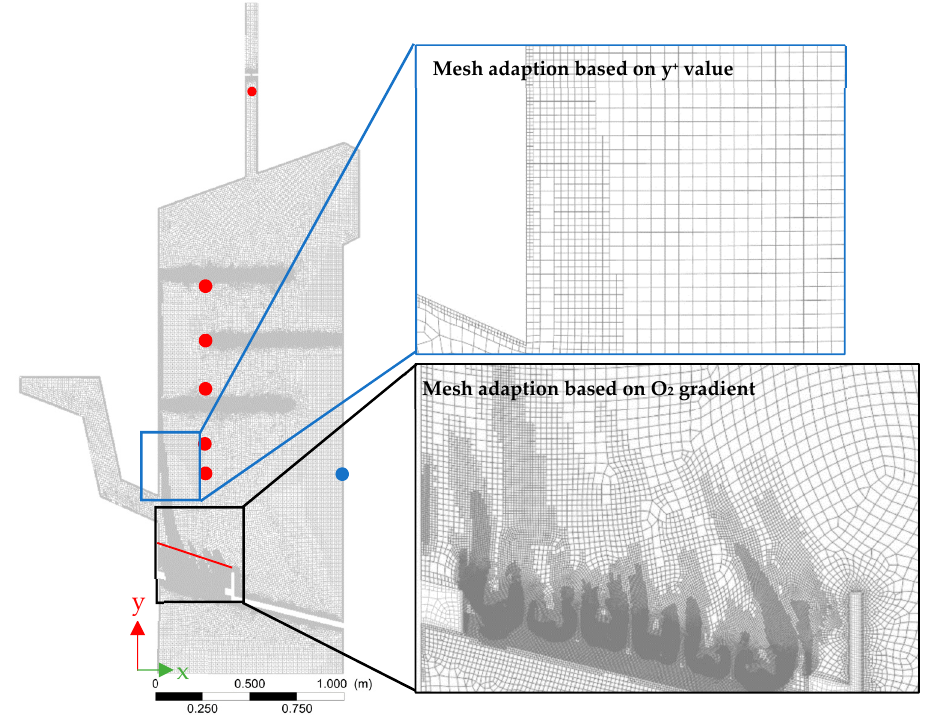
Figure 4. Simulation model for CFD analysis ( : temperature probes located at 100, 115, 145, 175, 205, and 305 cm from ash pit; : wall temperature probe at 100 cm from ash pit; solid red line: particle injection surface).